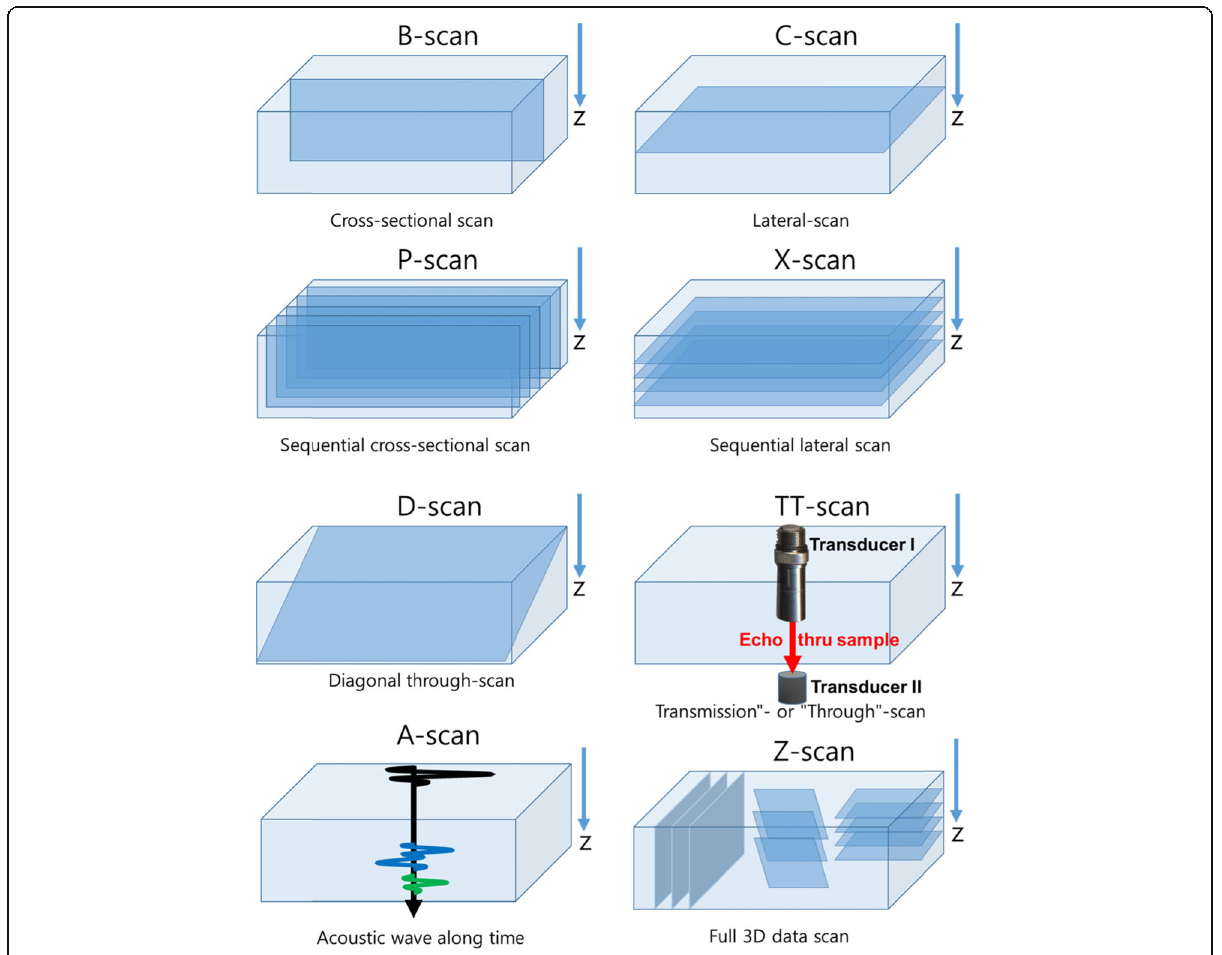
Fig. 3 Different types of scanning analytical modes of